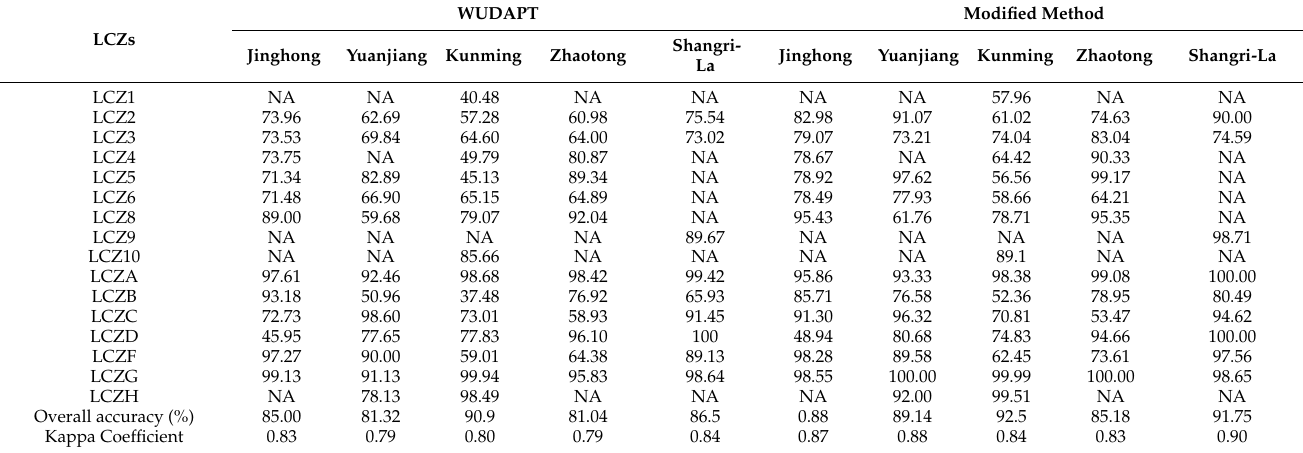
Table A2. The accuracy of LCZ classifications (NA represents no-data